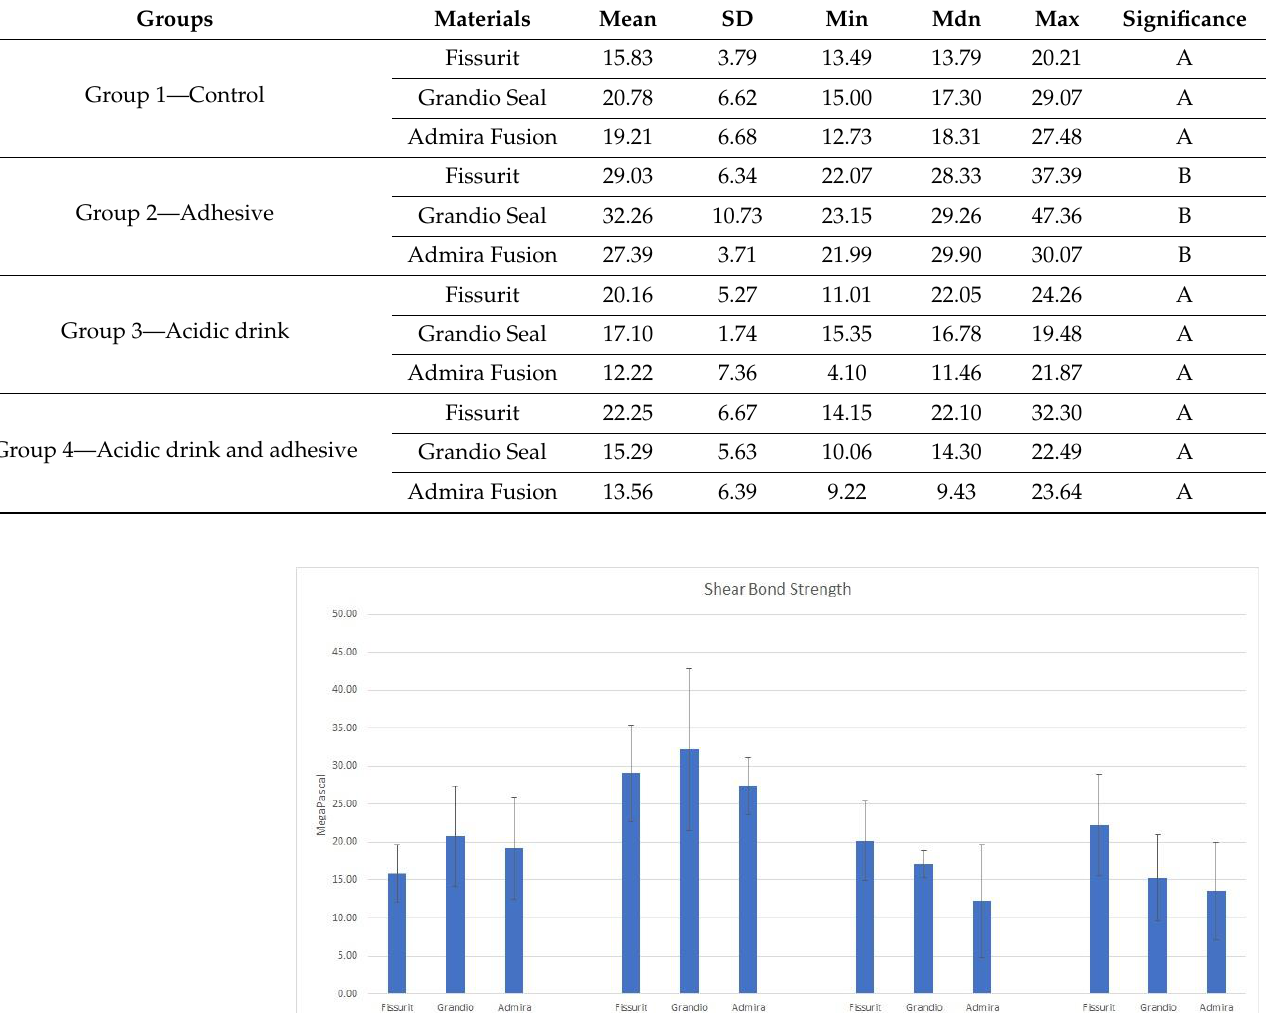
Table 2. Descriptive statistics (in MPa) of shear bond strengths of the 3 materials tested for each experimental Group. SD: Standard deviation. Different capital letters in the Significance column indicate significant differences in MPa for bond strength ( p < 0.05).